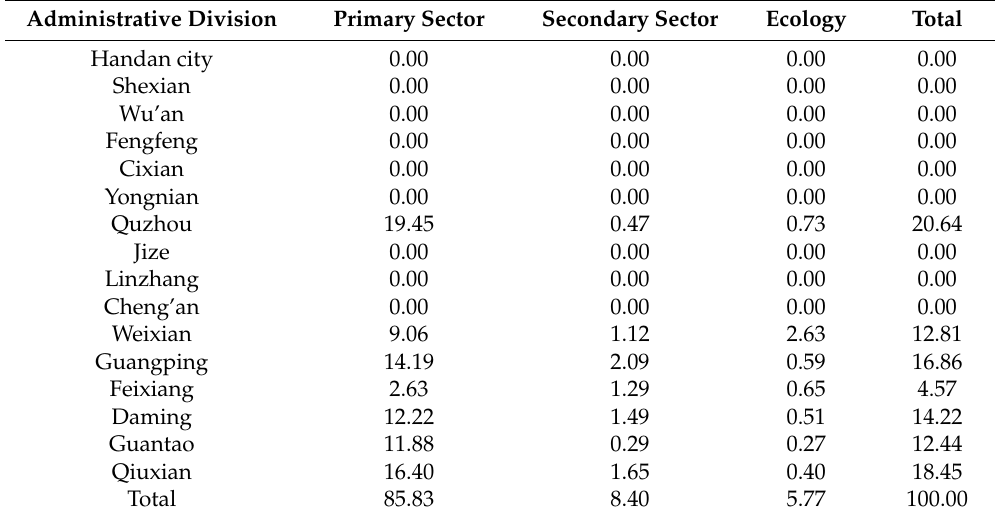
Table 10. Results for Yellow River transferred water allocated to every user (10 6 m 3 ).